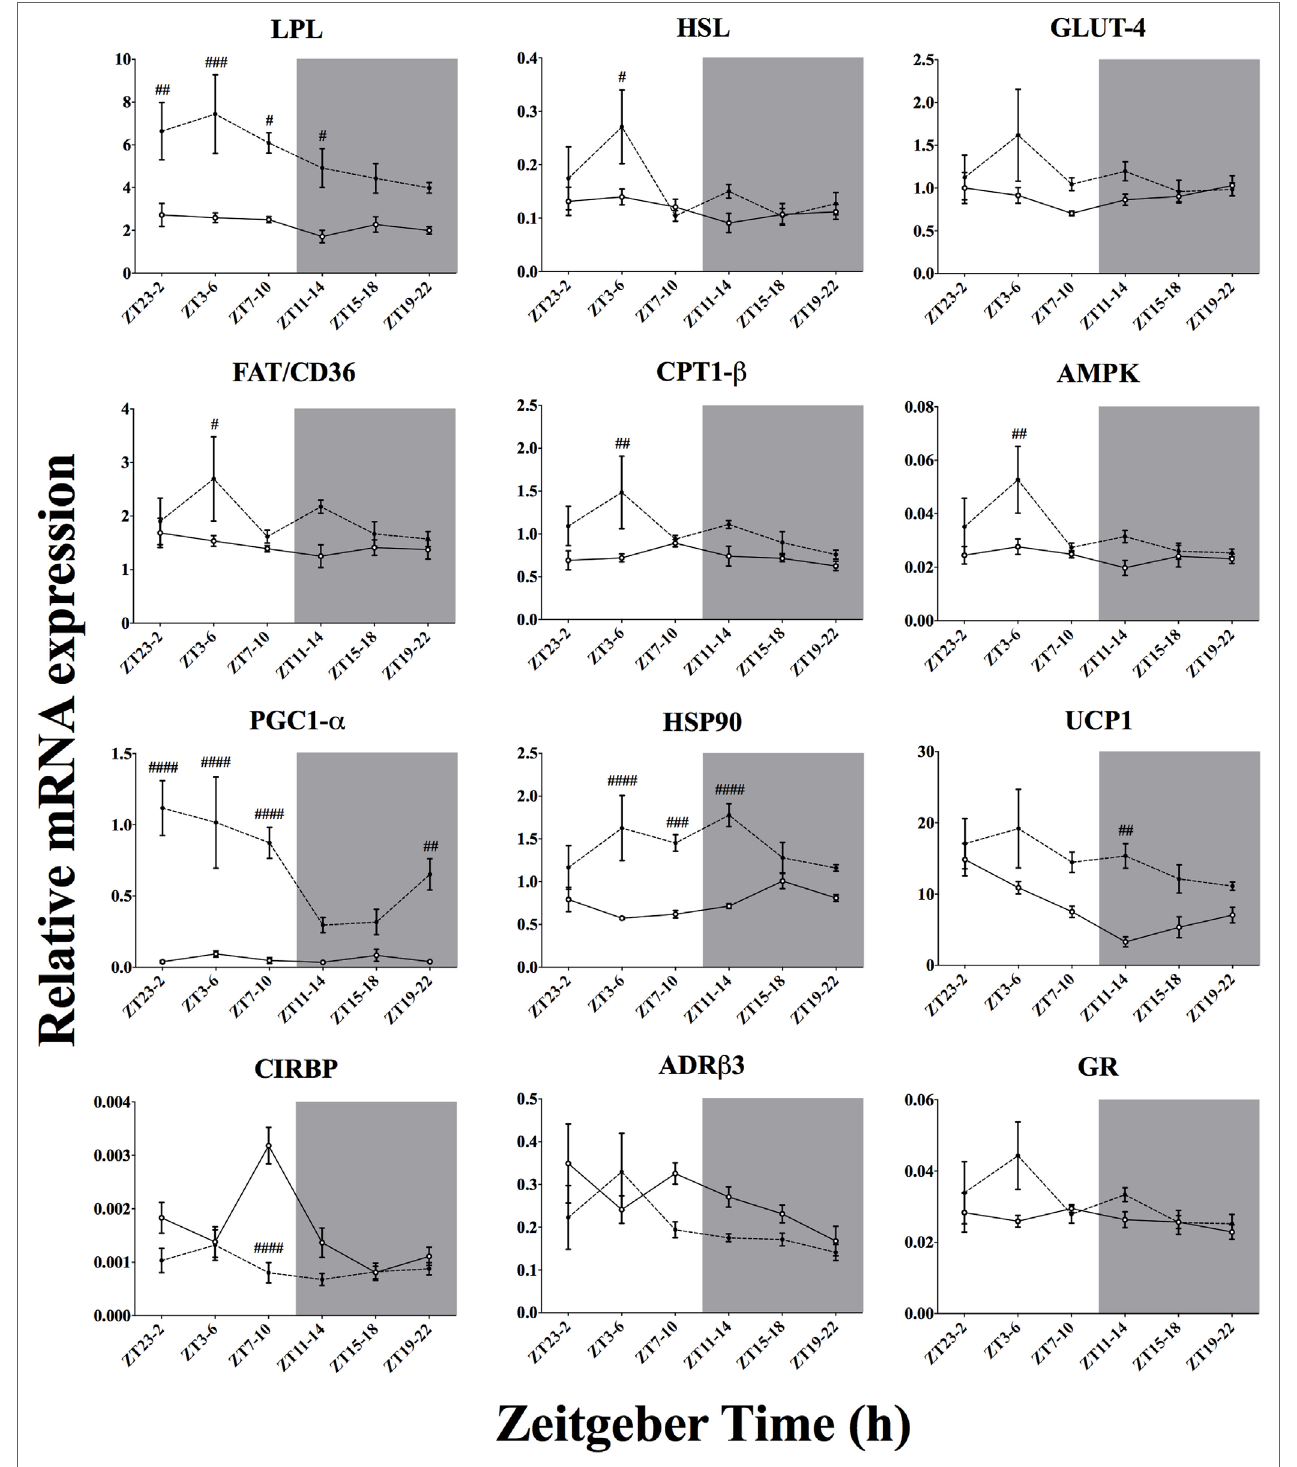
FigUre 7 | Effect of time­of­day on metabolic gene expression in brown adipose tissue (BAT) after exposure to environmental cooling. Light phase began at Zeitgeber Time 0 (ZT0) and dark phase (shaded areas) began at ZT12. Results are presented as mean ± SEM. # indicates differences between control and cold conditions, p < 0.05 . n = 5–7/group/ZT. Data for CREB, PGC1­ β , PPAR­ α , PPAR­ γ , ACC1, and ACC2 are not shown (refer to Table 4 for results).